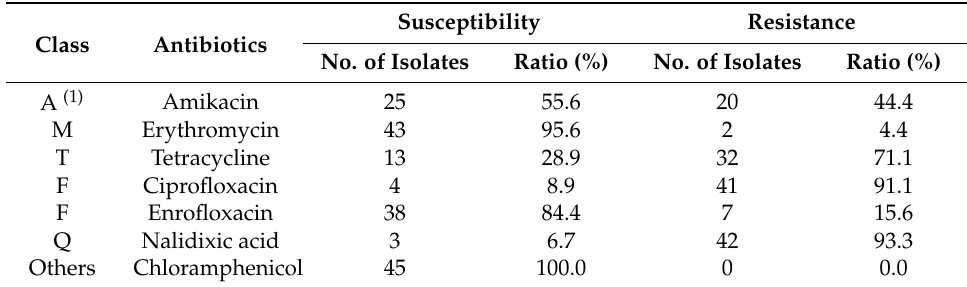
Table 4. Percentage of susceptibility and resistance of seven antibiotics for Campylobacter isolates from